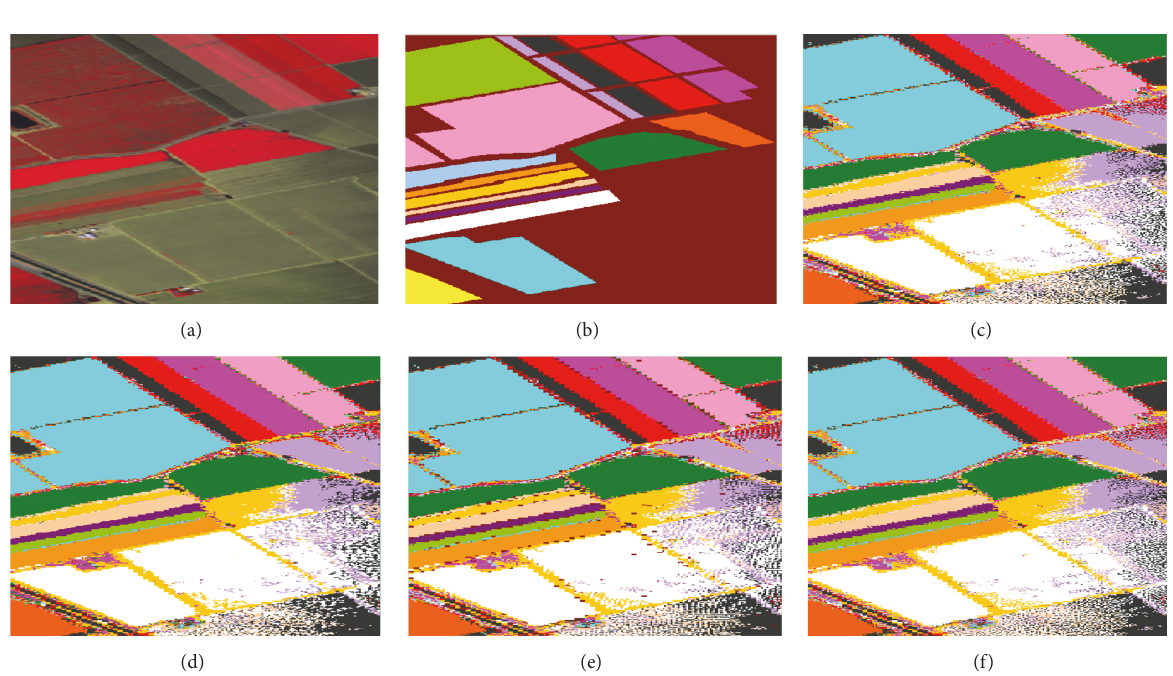
Figure 11: The subpixel mapping results of the PaviaU original subimages: (a) pseudocolor image, (b) true distribution, (c) random distribution, (d) GMBQPSO, (e) GBQPSO, and (f)